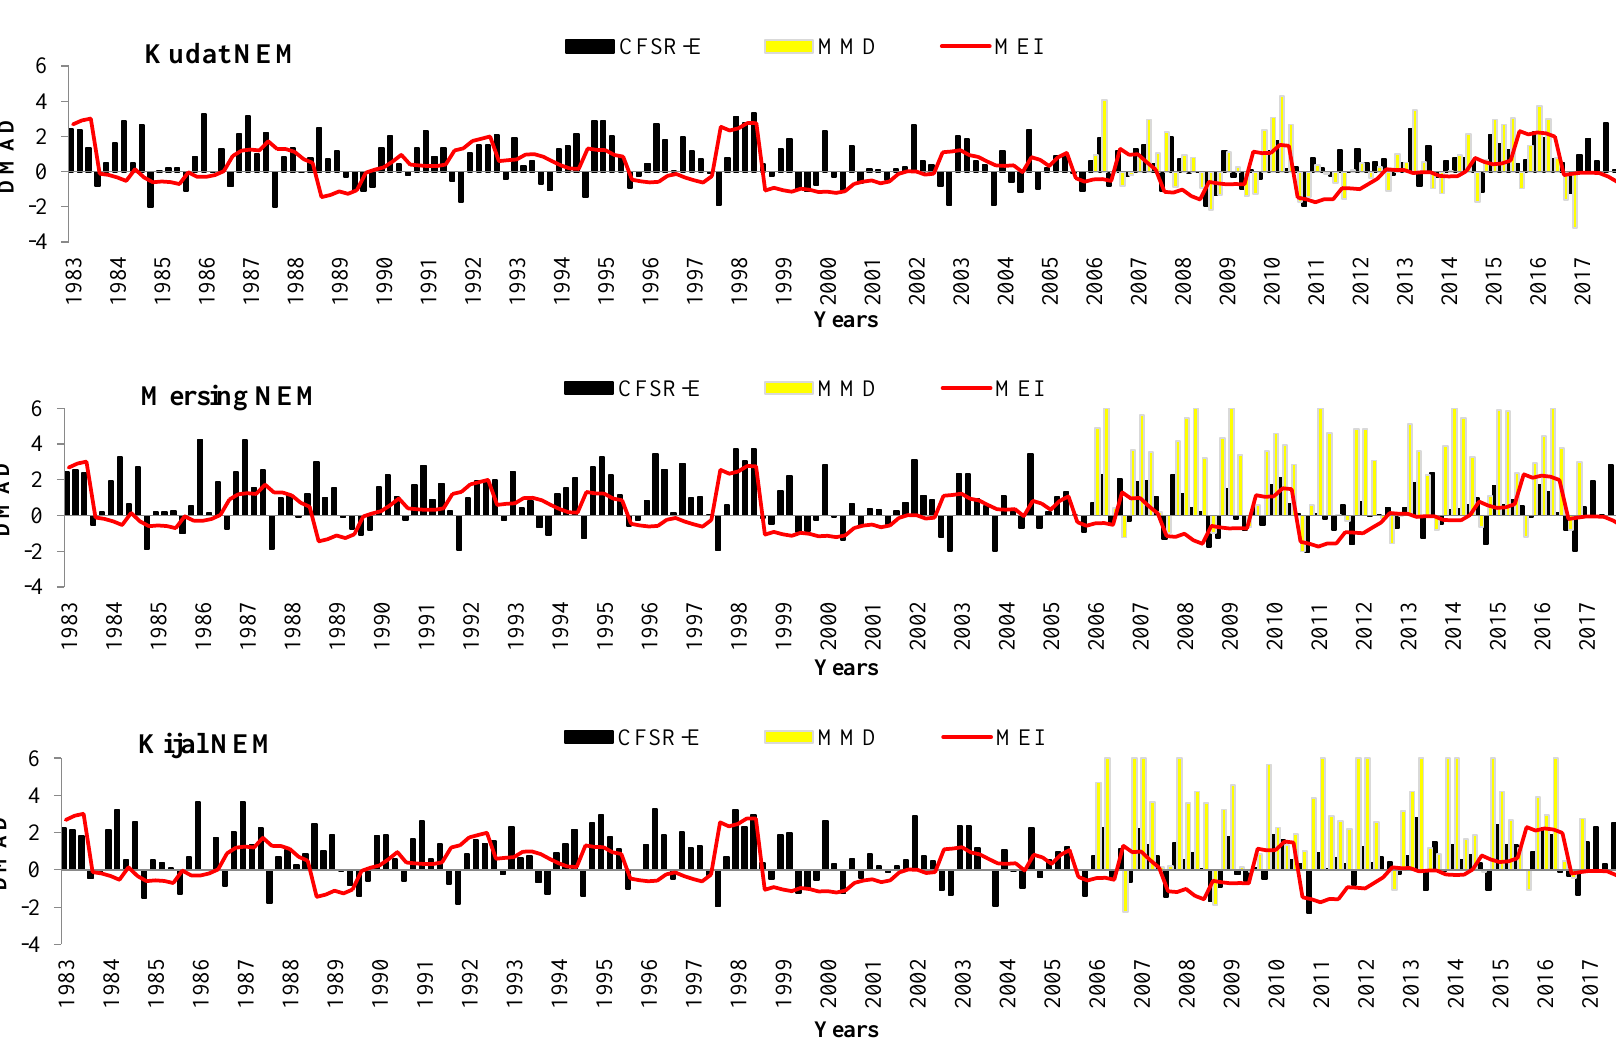
Figure 2. The dimensionless median absolute deviation (DMAD) for CFSRE and MMD data during the Northeast monsoon (NEM) season.